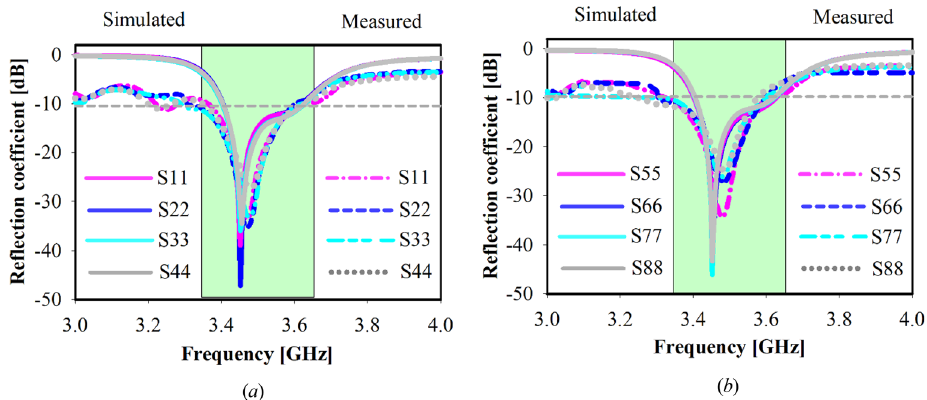
Figure 13. Reflection coefficient for different ports: simulated and measured, ( a ) Port 1–4, ( b ) Port